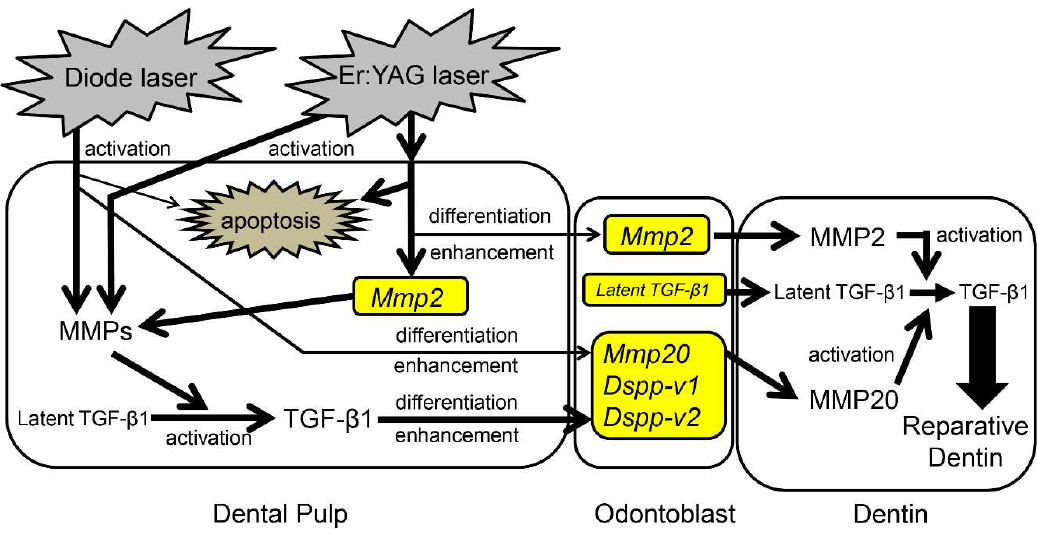
Figure 8. Proposed biological reaction mechanism in porcine dental pulp cells and tissues induced by Er:YAG-LI and diode-LI.